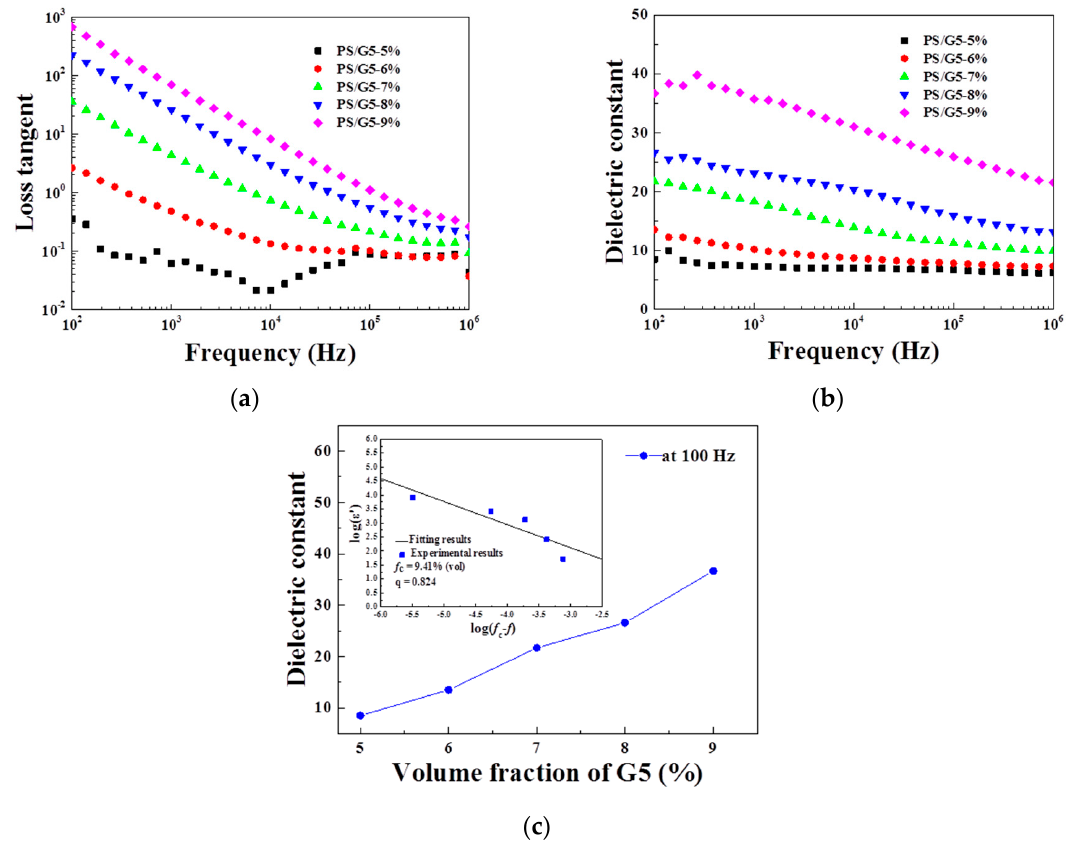
Figure 3. Frequency dependence of dielectric properties for polystyrene/graphene nanoplatelets (PS/G5) composites with different filler volume fractions: ( a ) dielectric loss; ( b ) dielectric constant; and ( c ) the best linear fits for ε ’ at 100 Hz for PS/G5 composites with different volume fractions by the percolation theory shown in Equation (1).